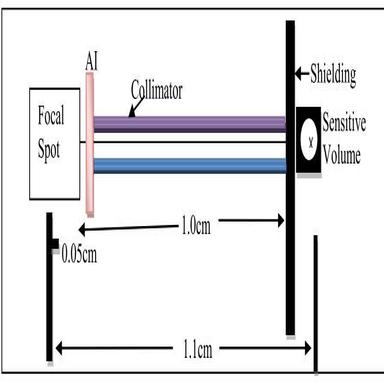
Illustration of the experimental set up.